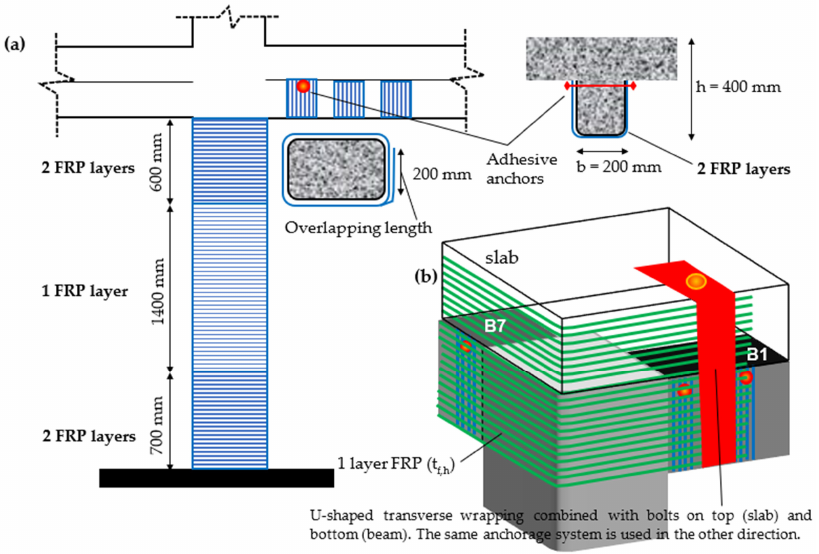
Figure 6. ( a ) FRP jacketing in ground floor columns and beam. ( b ) Strengthening of corner joint B1-C1-B7. Beam-Column Joint